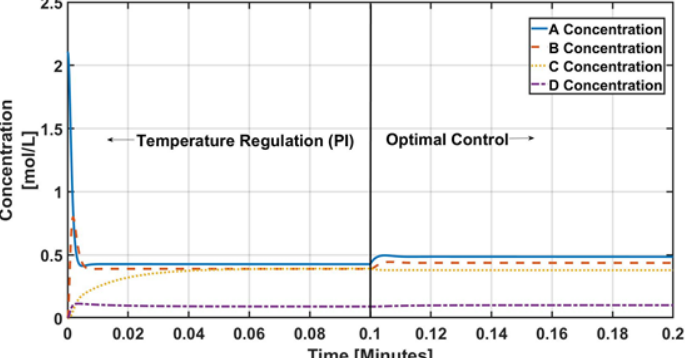
Figure 4. Closed-loop dynamic behavior of